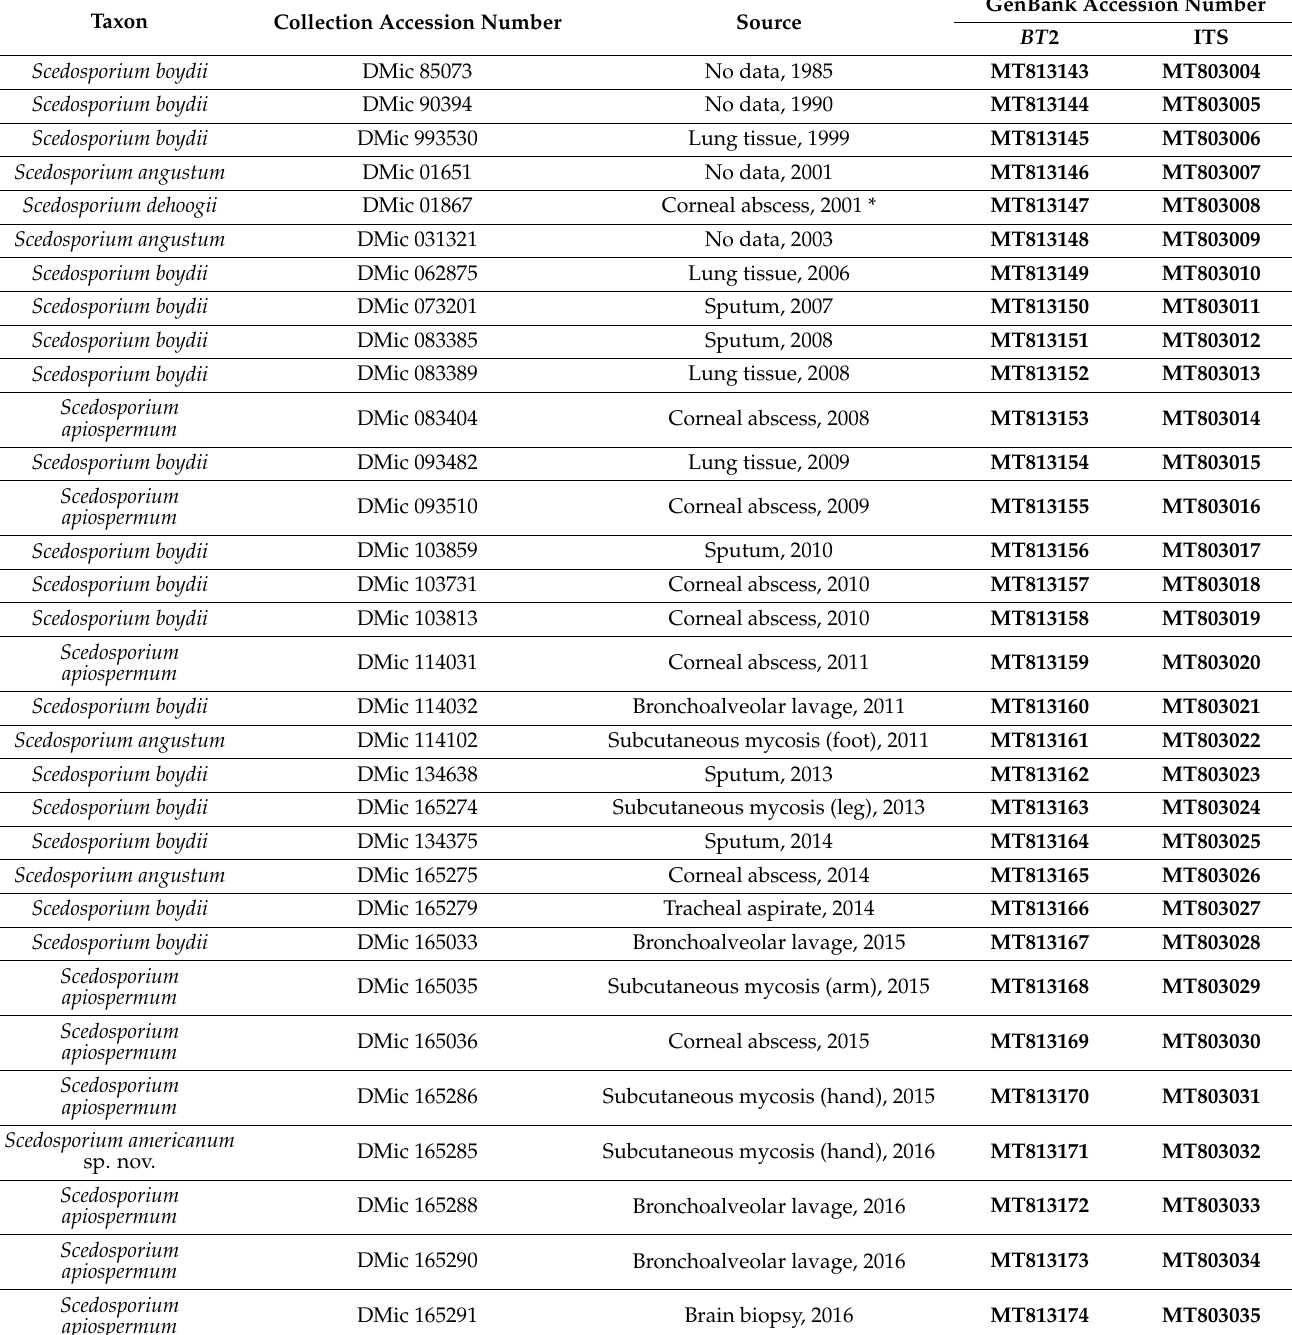
Table 1. Strains and sequences used in the